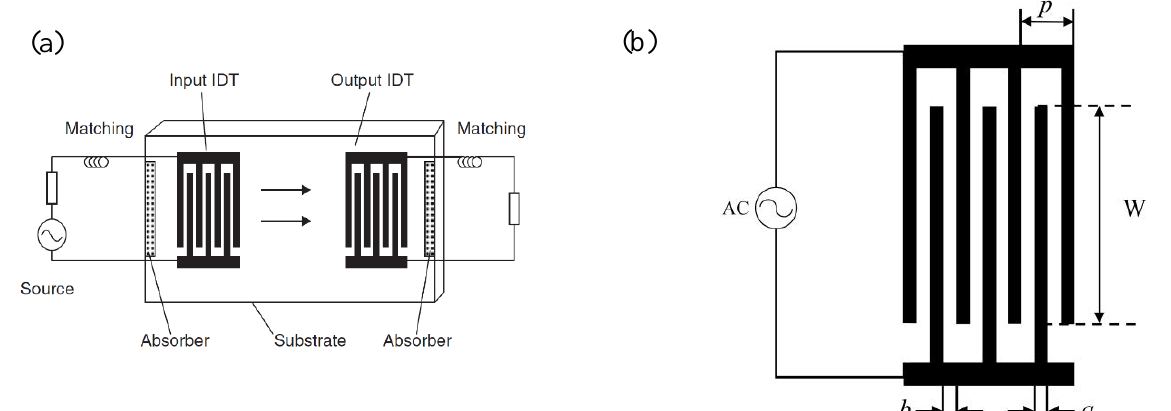
Figure 2. (a) Schematic diagram of classic SAW resonator with delay line, adapted with permission from [4]; (b) the classic structure of IDT.